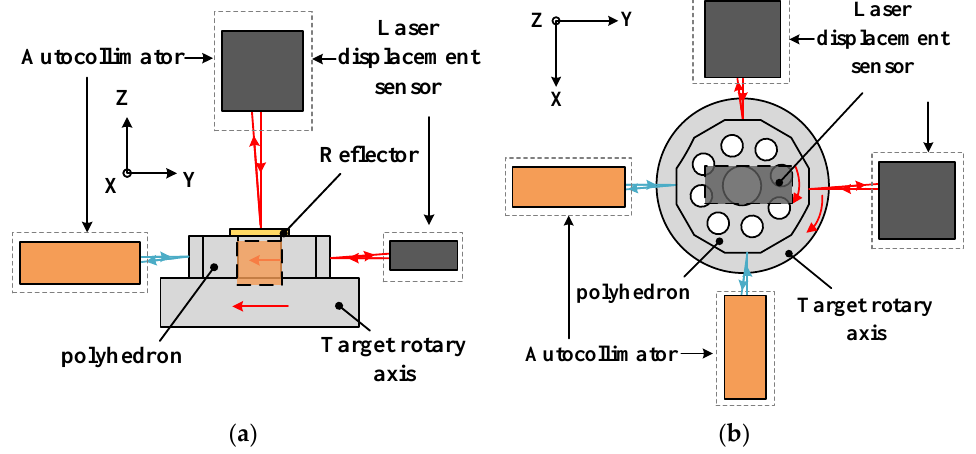
Figure 1. Measurement principle of six degrees of freedom (DOF) motion errors of a rotary axis based on a polyhedral prism. ( a ) Front view. ( b ) Top view.